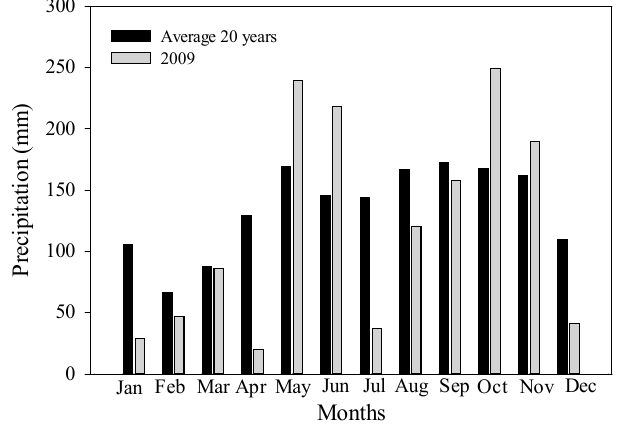
Figure 1. Average monthly precipitation in 2009 versus average monthly precipitation from the past 20 years in the Sub-Agricultural Experiment Station of Isabela, Puerto Rico.